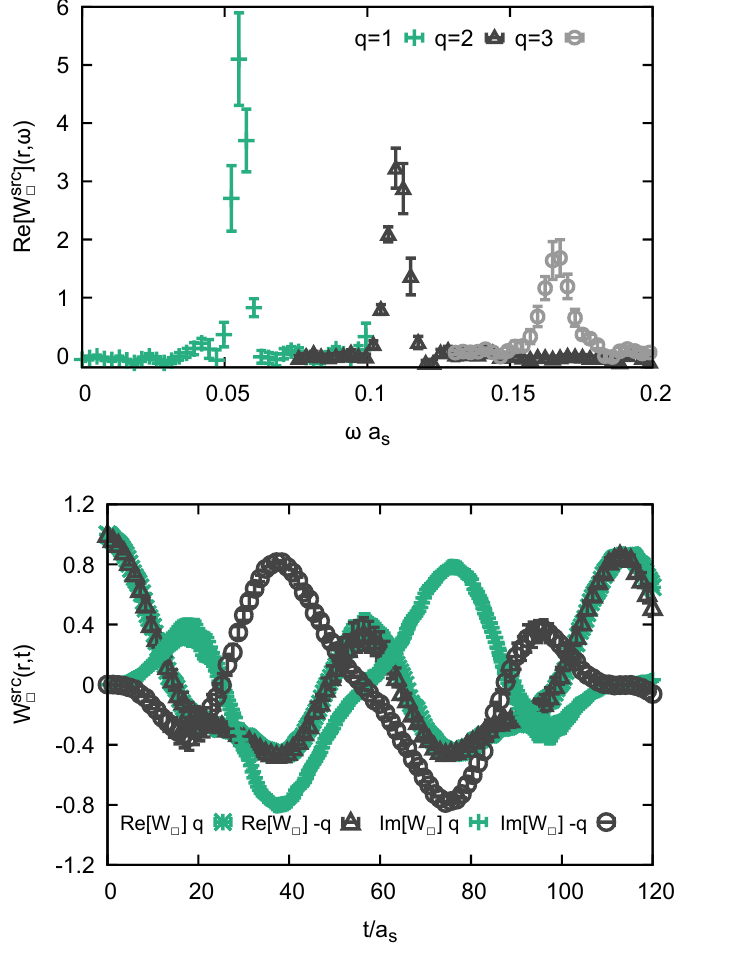
Figure 8 . (top) The spectral function of the trace of the Wilson loop evaluated for different strengths of the color charge q = 1 , 2 , 3 . We find that the position of the lowest lying spectral peak shifts linearly with the charge, as expected in the Abelian theory. (bottom) Comparison of the coordinate space Wilson loop for charges of the same magnitude but flipped signs. One finds agreement in the real-part and a flip of sign in the imaginary part, indicating that indeed Re[ V ] → − Re[ V ] as the sign of the charge